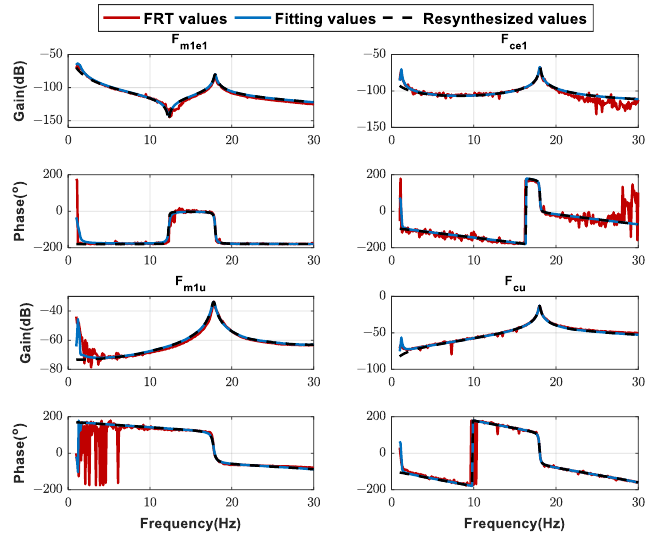
Figure 27. Examples of FRF fitting and resynthesis.